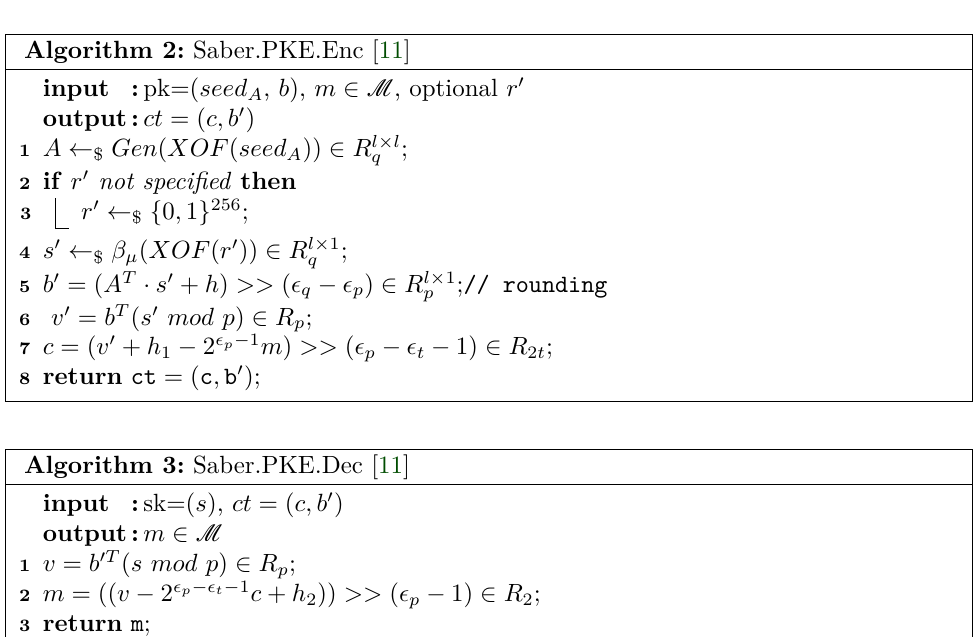
Algorithm 2: Saber.PKE.Enc [11]